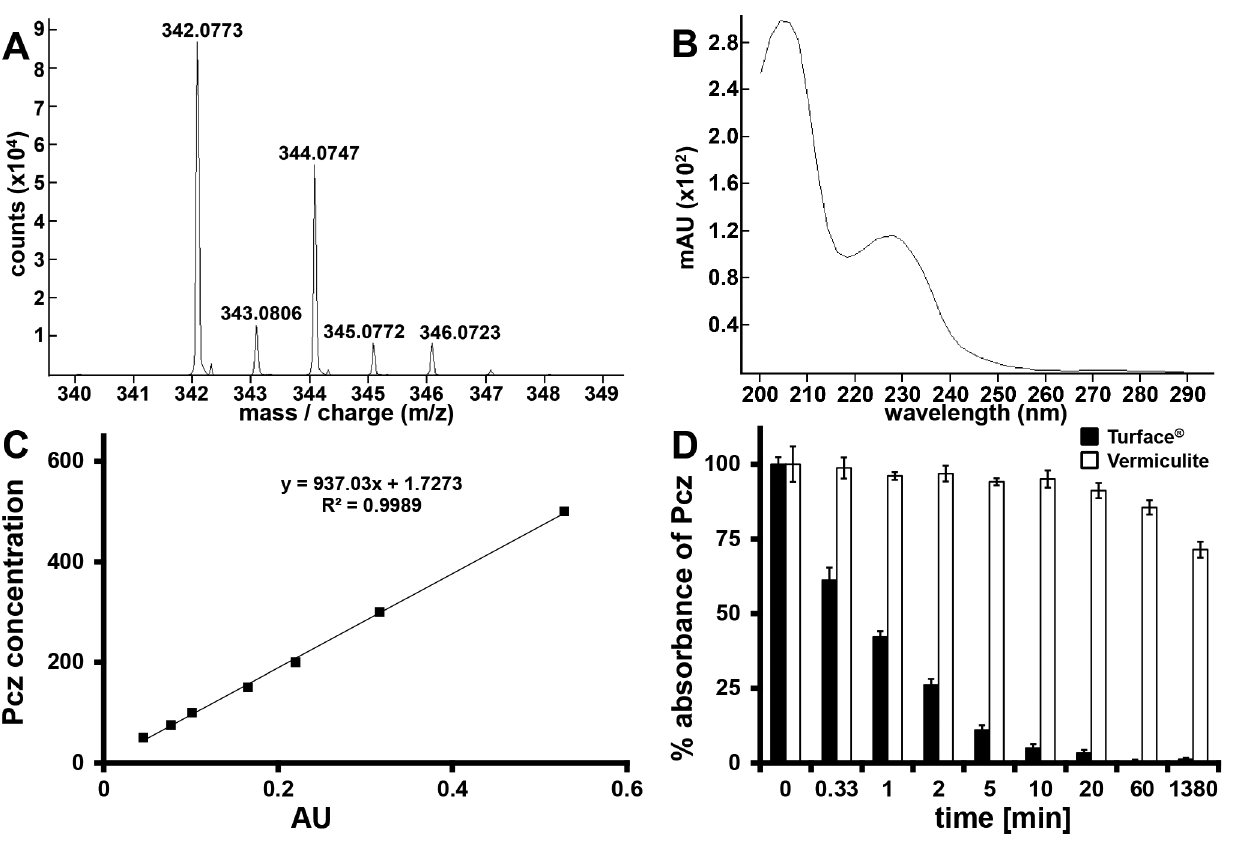
Figure 4. LC-MS, and standard curve of Pcz within solution. (A) LC-MS spectrum of Pcz. (B) photometrically determined absorption spectrum of Pcz measured from 200 nm to 350 nm. (C) Standard curve of Pcz concentrations from 0 to 500 mM plotted against absorption at 225 nm. (D) Absorbance kinetics of Pcz on Turface (black bars) and vermiculite (white bars) measured at 225 nm. Absorbance of Pcz to substrates was tested from 0 to 23 h.